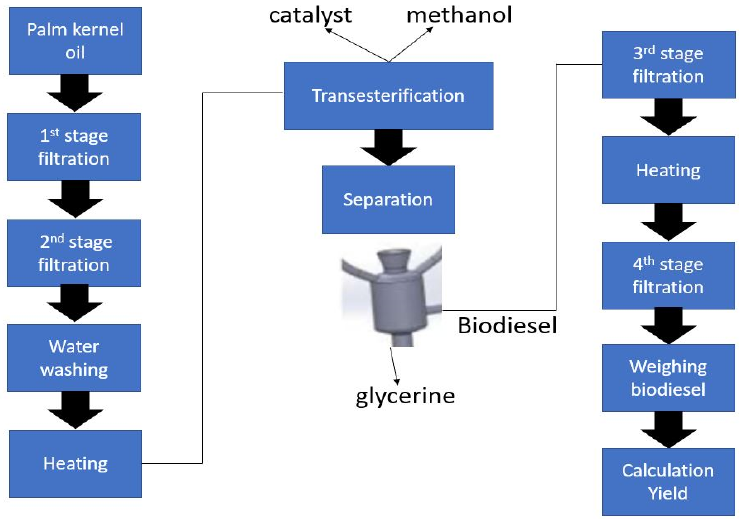
Figure 1. Flow chart of the transesterification process.